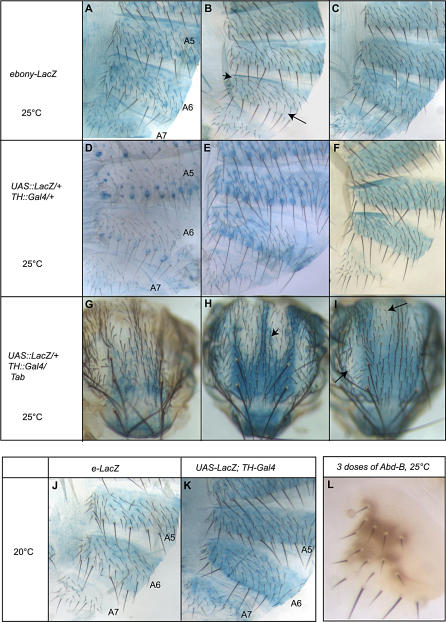
The Expression of Pigmentation Enzymes Is Highly Dynamic and Modulated by Temperature(A–C) Dynamic expression of ebony-LacZ at 25 °C in the abdomen of pharate adults. Expression is first visible at the base of bristles around 90 h after puparium formation in (A) and then extends progressively from the anterior region of the segments to all epidermal cells within tergites (B and C).(D–F) Dynamic expression at 25 °C of the tyrosine hydroxylase using TH-Gal4 and UAS-LacZ transgenes. Expression starts earlier than ebony-LacZ, at the base of the large bristles on the posterior border of the segments. In (D), the bristles are not mature yet. The expression is then visible at the base of smaller bristles (E), and eventually in all epidermal cells (F). Note that the most posterior tergite, A7, does not show any strong staining.(G–I) Dynamic expression of the tyrosine hydroxylase using TH-Gal4 and UAS-LacZ transgenes in Tab/+ females at 25 °C at 90 h after puparium formation. Thoraces have an increasing age from left to right, as revealed by the pigmentation at the base of bristles. The abdomen and thoraces shown within the same column do not necessarily have exactly the same age. See text for details.(J) Expression of ebony-LacZ in female abdomen just before hatching at 20 °C. No strong expression is visible in A7.(K) Expression of the tyrosine hydroxylase visualized using TH-Gal4, UAS-LacZ in female abdomen just before hatching at 20 °C. The expression in A7 is much more visible than at 25 °C. In limiting conditions, such as in females with three doses of Abd-B grown at 25 °C, the melanin almost completely disappears from A7 and remains only at the first sites of expression of TH associated with bristles (L).